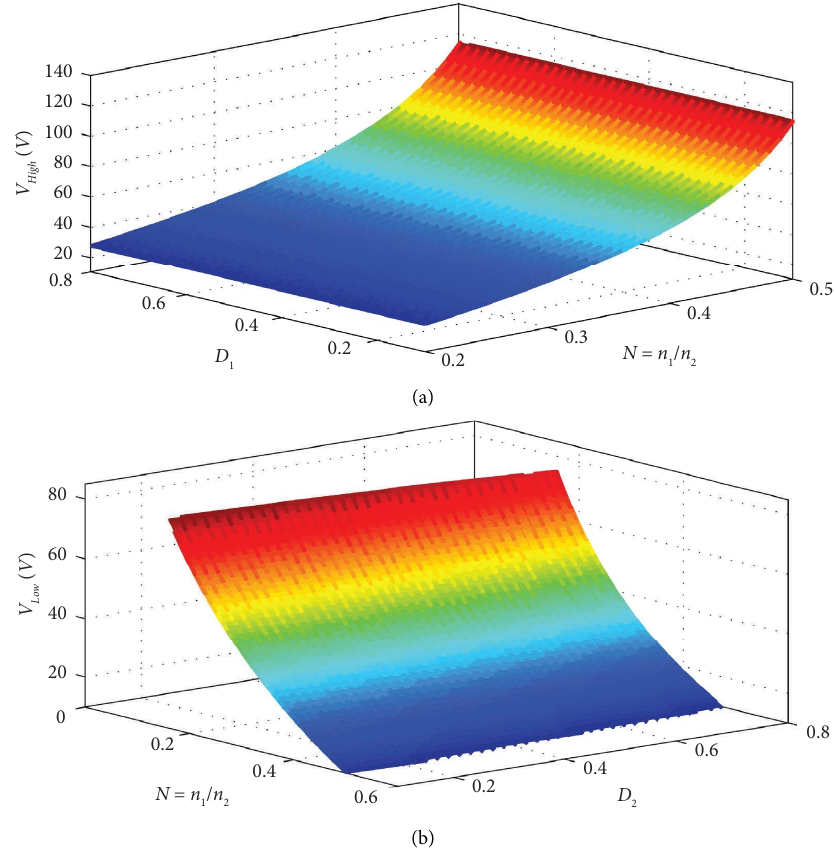
Figure 6: 3D view of the voltage gains versus duty cycle: (a) step-up and (b)